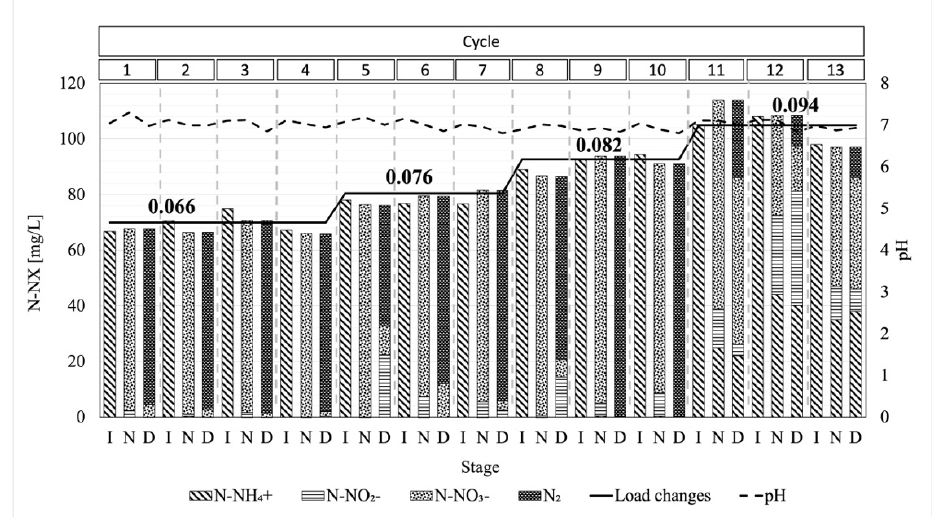
Figure 5. Results of the sequential aDN process. Nitrogen balance R0. Beginning of the cycle (I), end of the nitrification phase and beginning of denitrification (N), and end of denitrification (D). Numbers above black line represent NRL: kg N/(m 3 ·d).